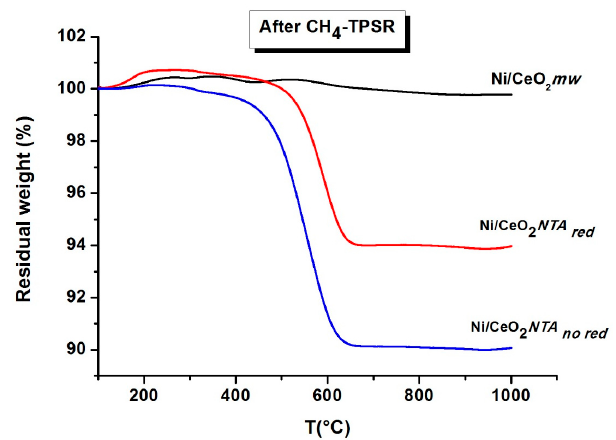
Figure 5. TGA profiles of nickel catalyst after methane CH 4 -TPSR test.